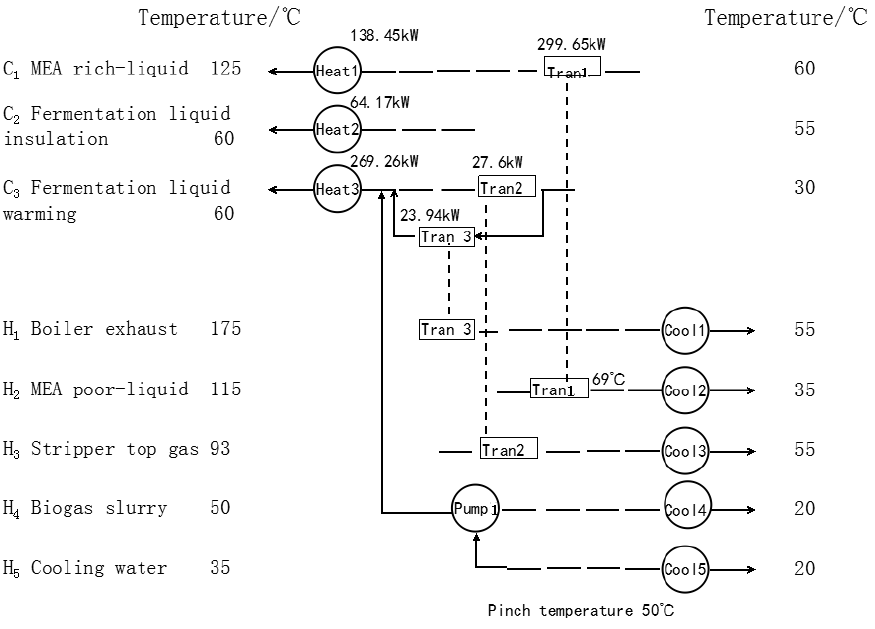
Figure 9. Plan for waste heat utilization.